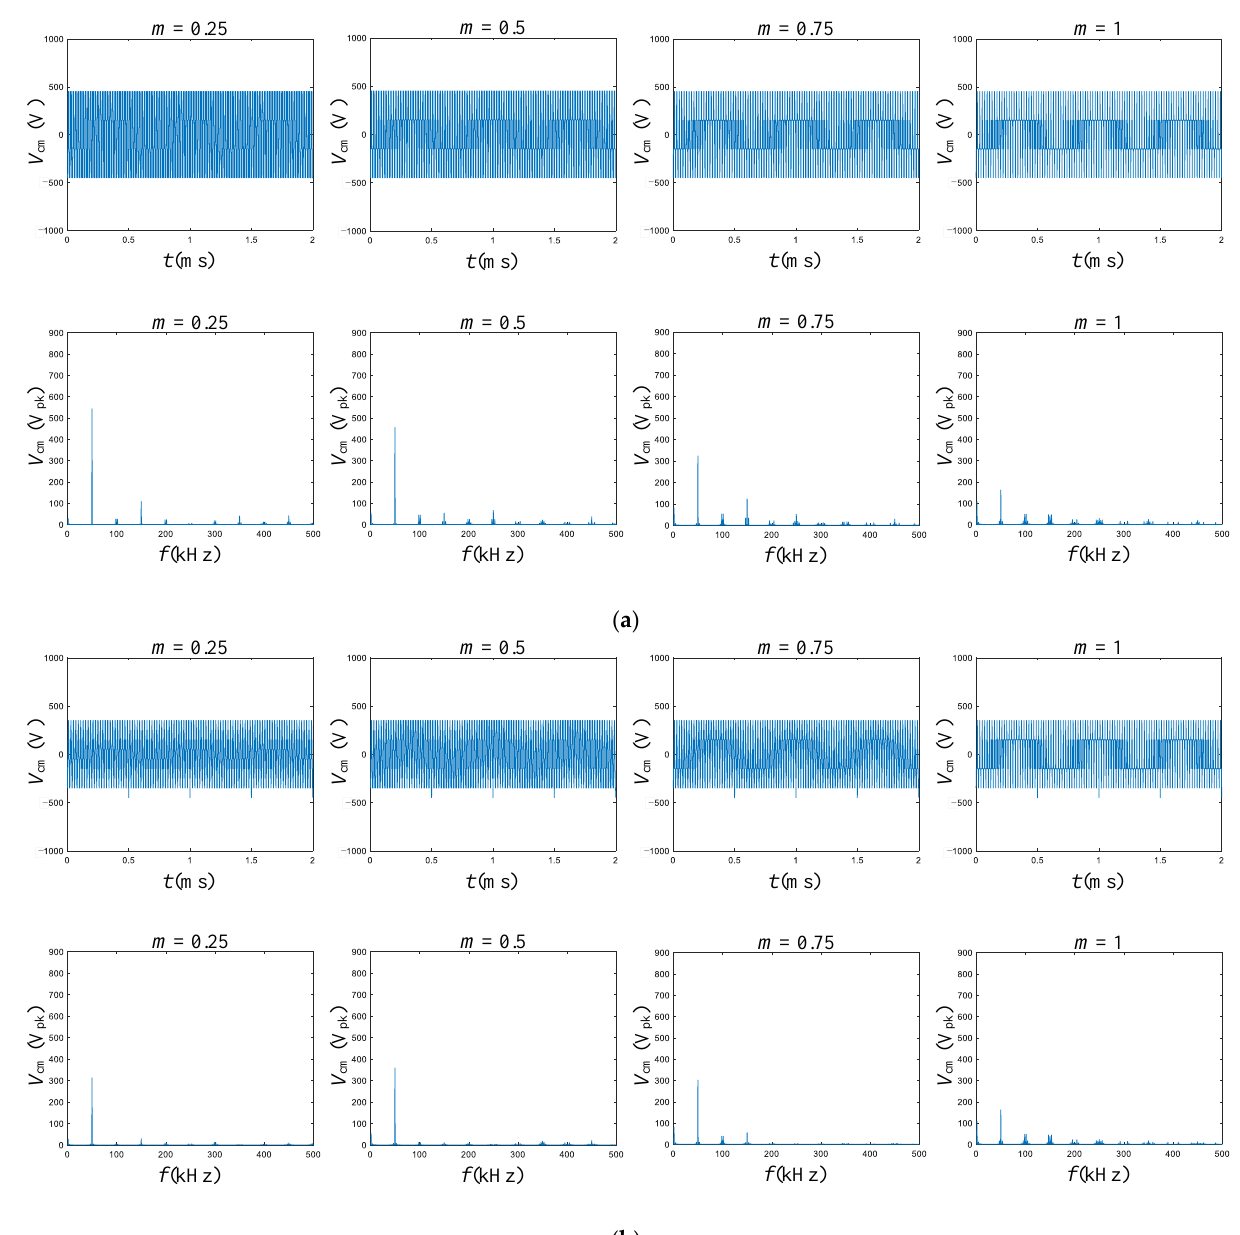
Figure 12. Time-domain and frequency-domain plots of the common-mode voltage in EV 3 under different modulation index values. ( a ) Design A. ( b ) Design B.